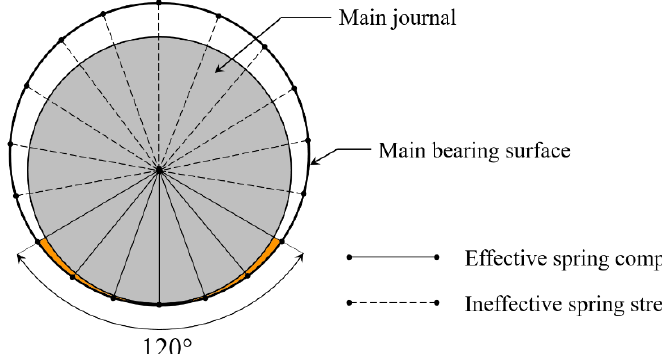
Figure 7. Simplified main journal–main bearing interaction model.